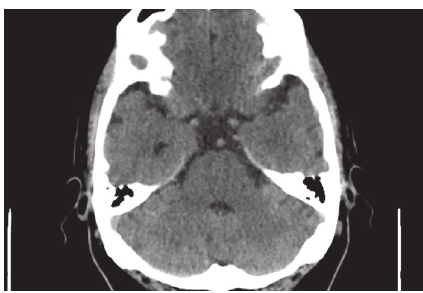
Figure 1: Baseline computerized axial tomography image without acute changes.